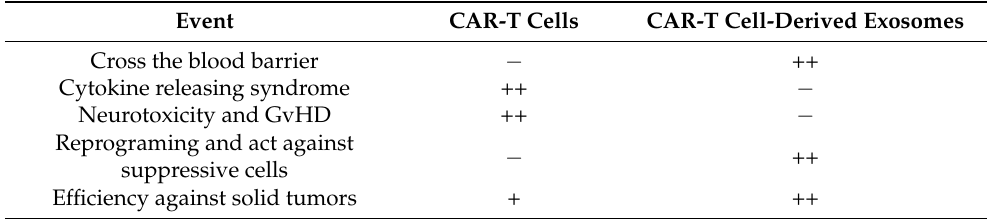
Table 5. Comparison of CAR-T cells and CAR-T cell-derived exosomes [141]. Event CAR-T Cells CAR-T Cell-Derived Exosomes Cross the blood barrier − ++ Cytokine releasing syndrome ++ − Neurotoxicity and GvHD ++ − Reprograming and act against suppressive